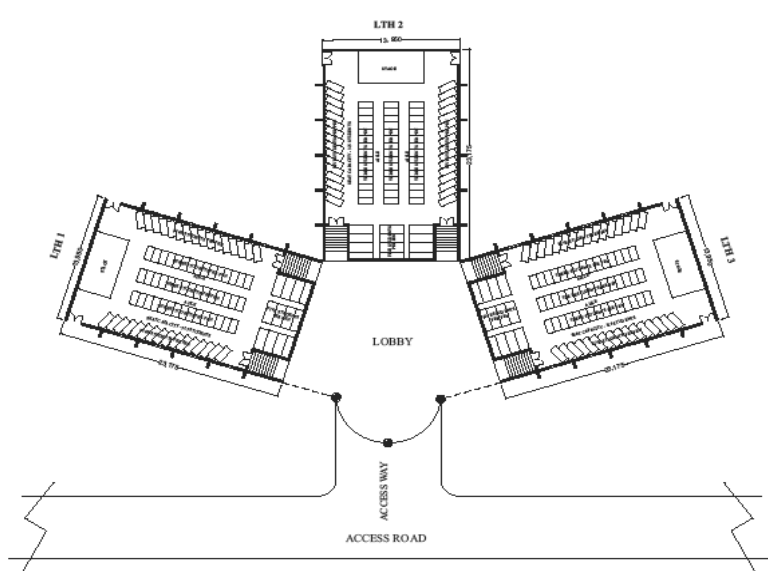
Figure 1. Floor plan of the lecture theatre (LHT).